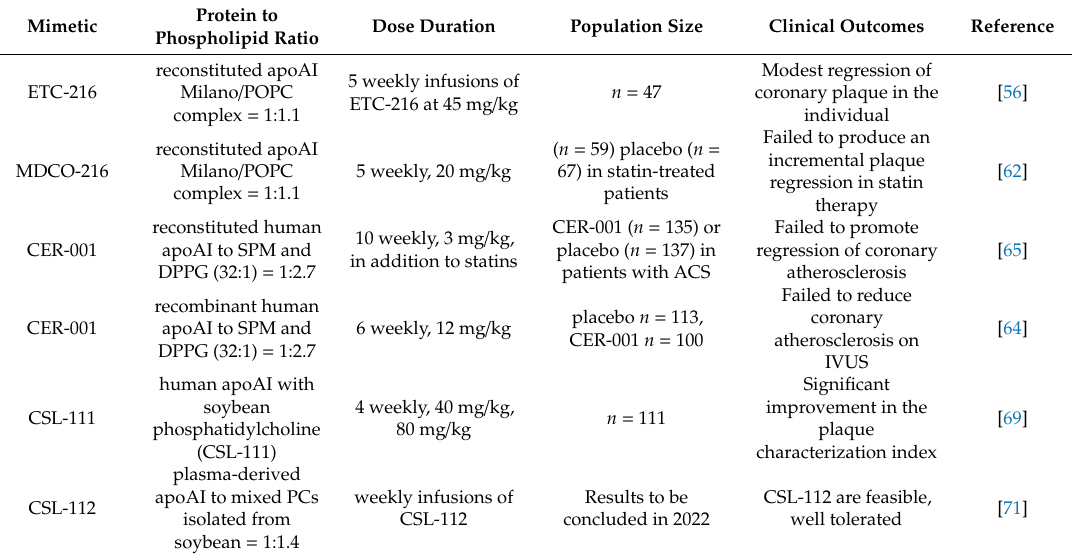
Table 1. Reconstituted HDL nanoparticles studied in clinical